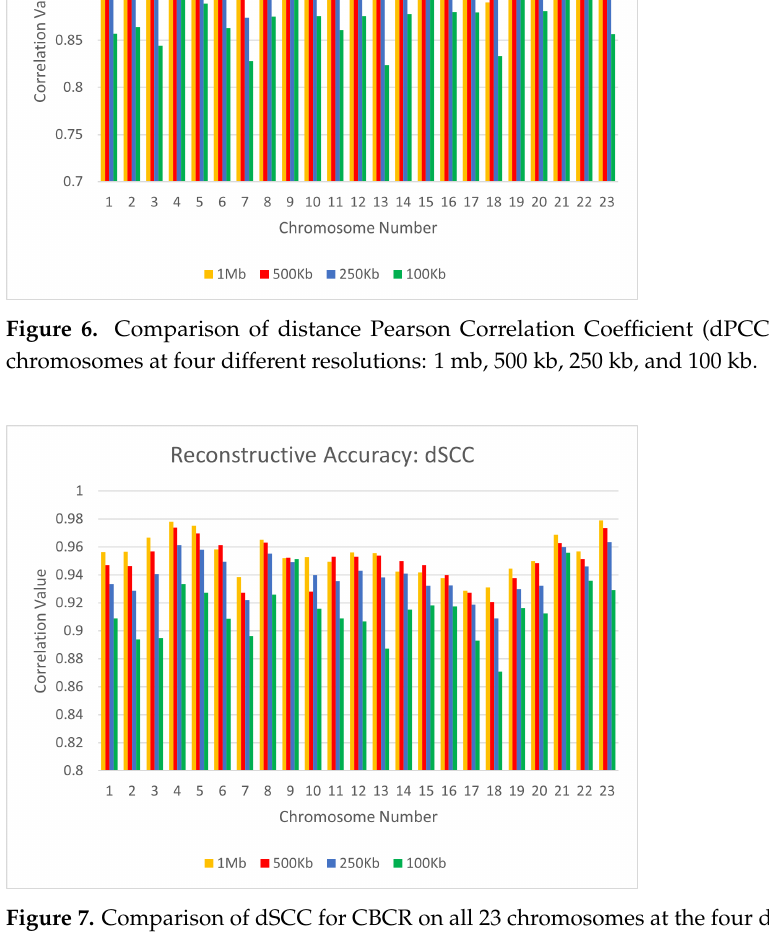
Figure 7. Comparison of dSCC for CBCR on all 23 chromosomes at the four different